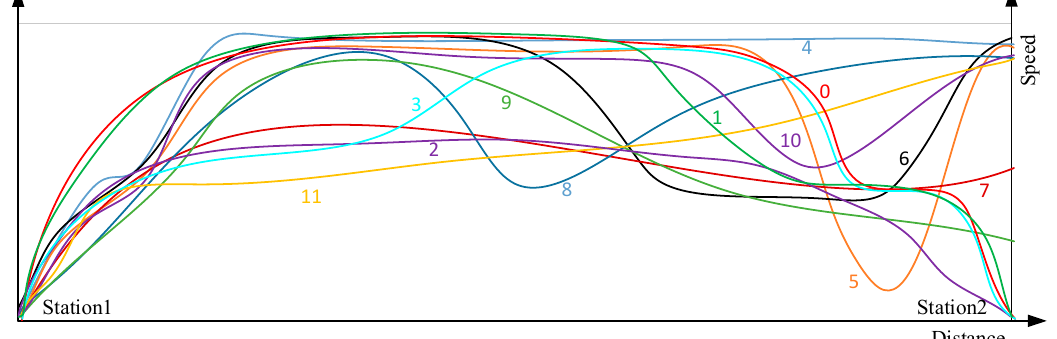
Figure 2. Examples of MDRT.